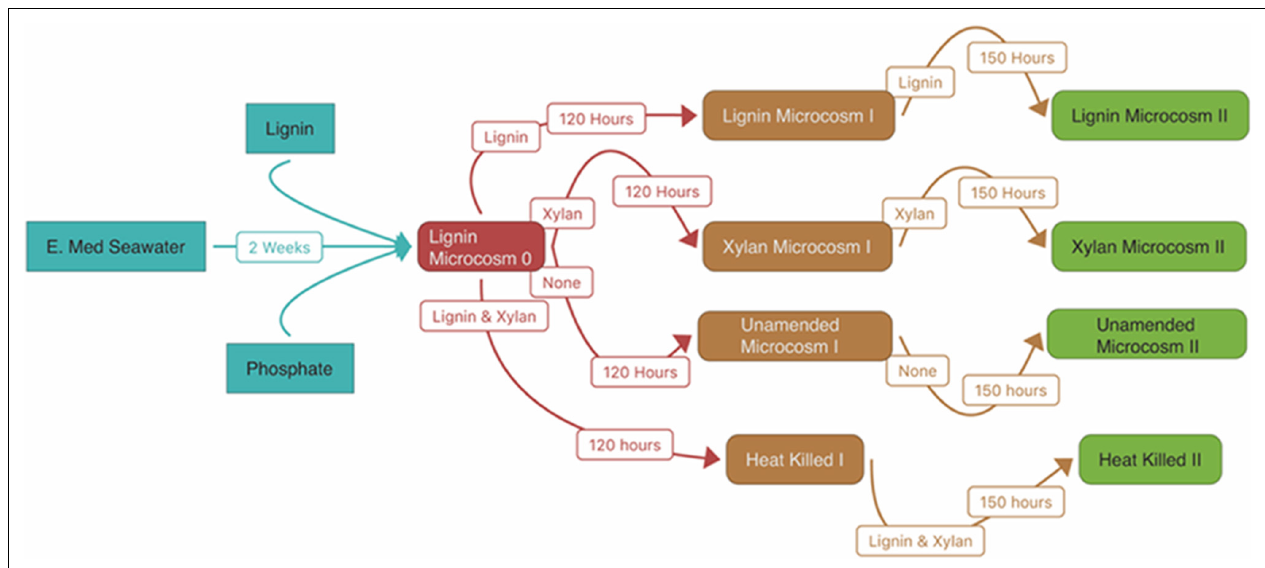
FIGURE 8 | Experimental design. The arrows indicate the inoculation of each substrate-adapted consortia. The white boxes indicate the substrates amended in the microcosm and the length of the